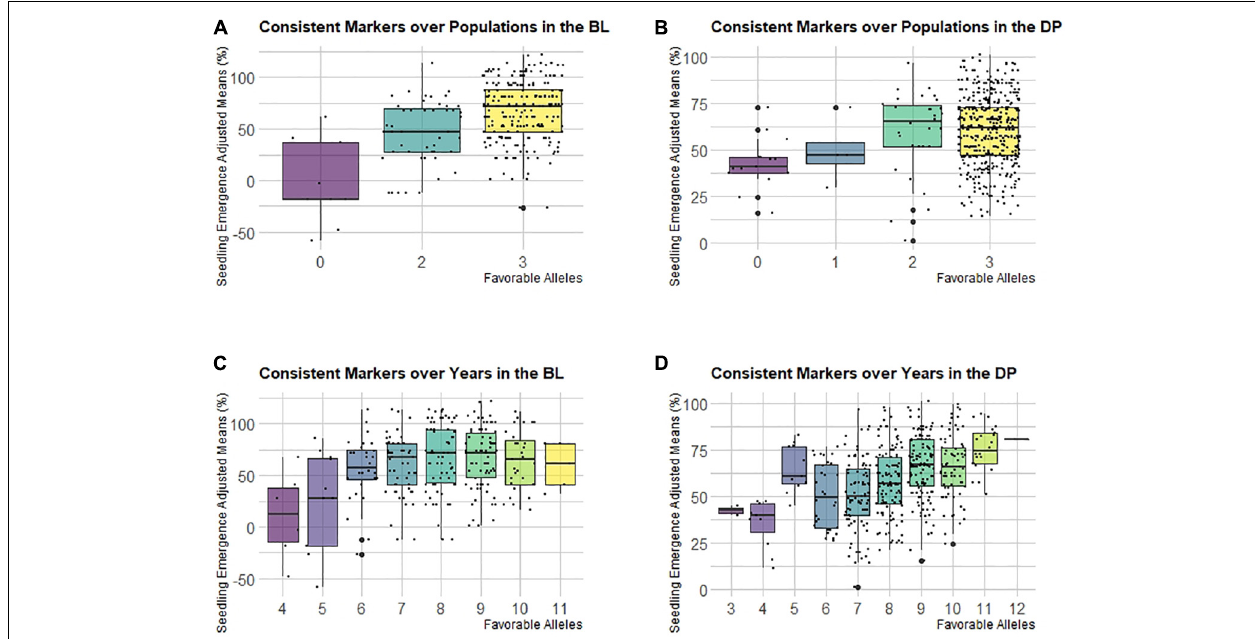
FIGURE 8 | Effect of pyramiding favorable alleles for seedling emergence for the consistent markers identified in both populations (A,B) , and consistent markers identified across years in the DP (C,D) across both the (A,C) diversity panel (DP), and (B,D) BL